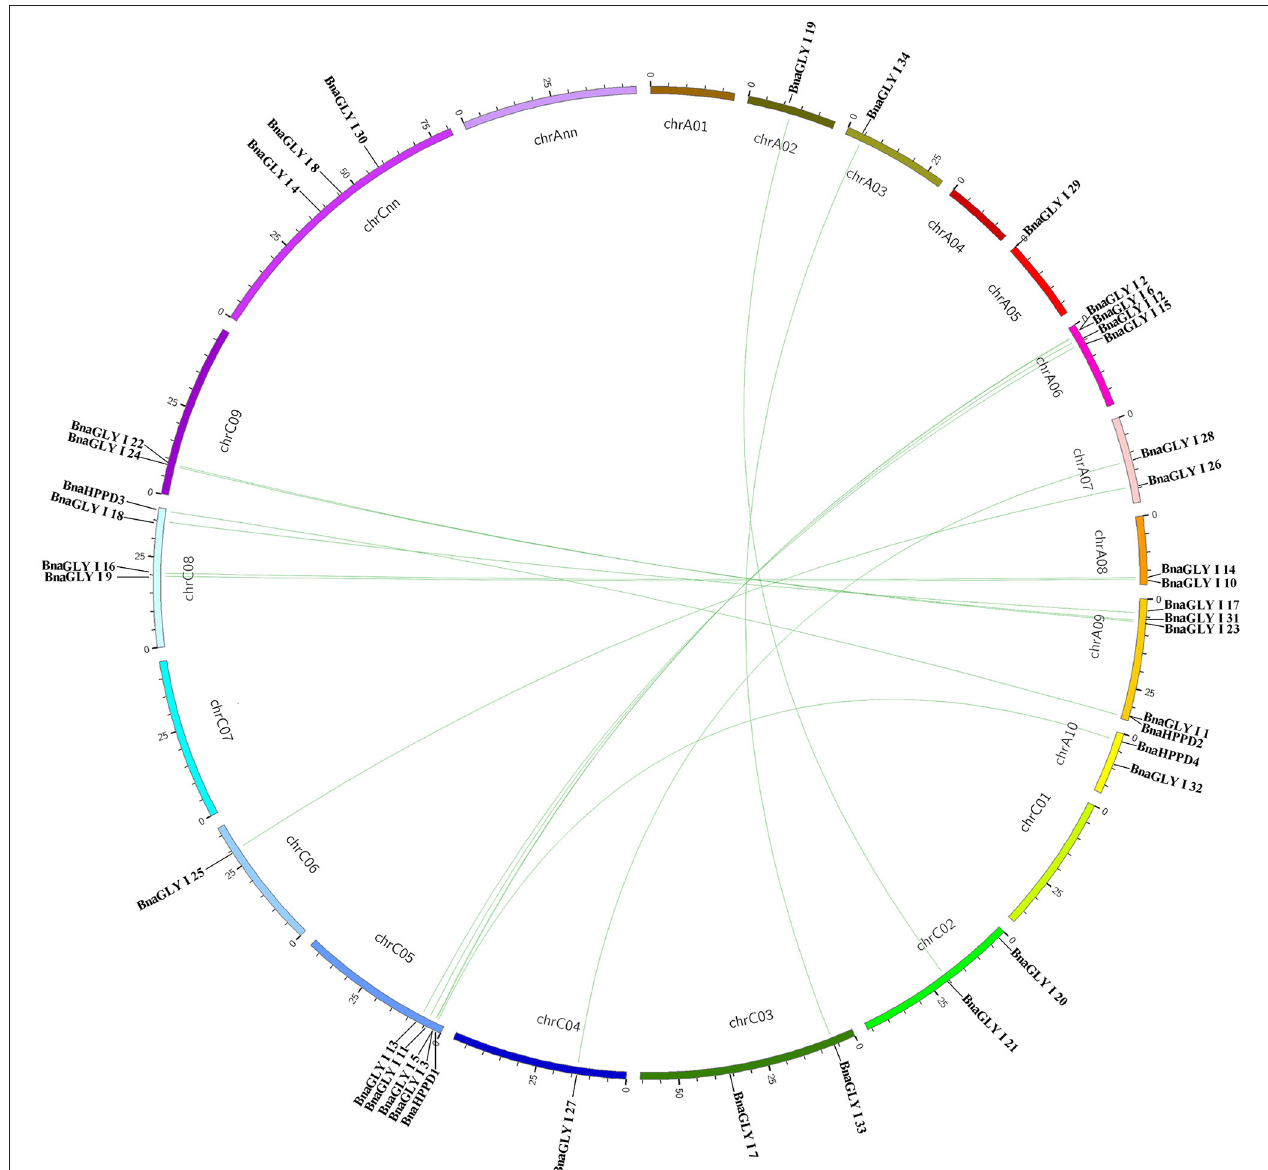
FIGURE 2 | Distribution of BnVOC gene family members on B. napus chromosomes. The BnVOC genes that chromosomal information was available in the database were mapped to the B. napus chromosomes and synteny relationship were lined.